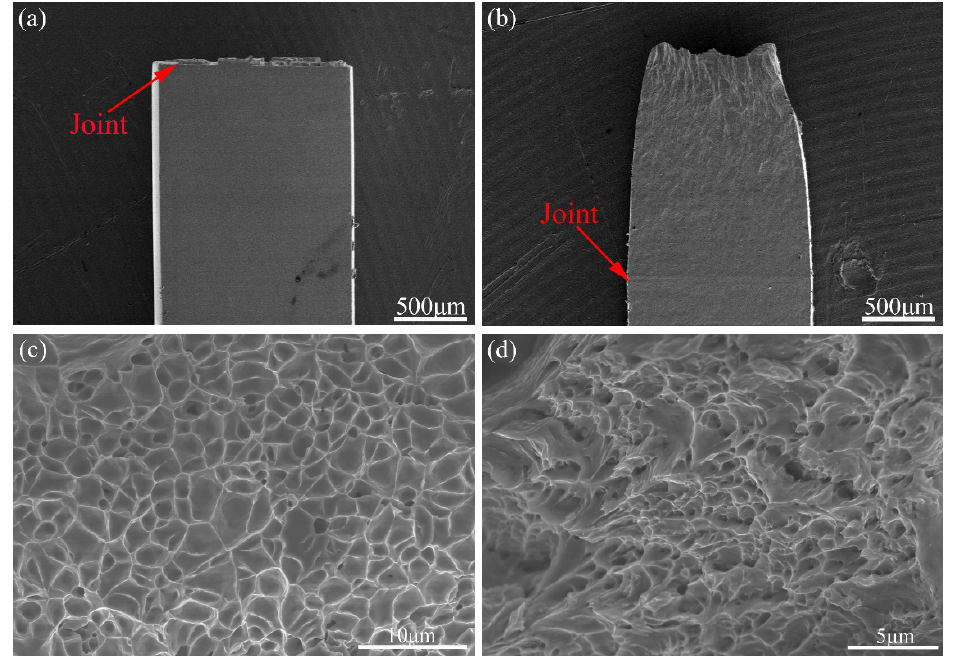
Figure 11. Fracture morphology analysis of the joint surface: ( a , c ) prior to tempering treatment and ( b , d ) subject to tempering treatment.